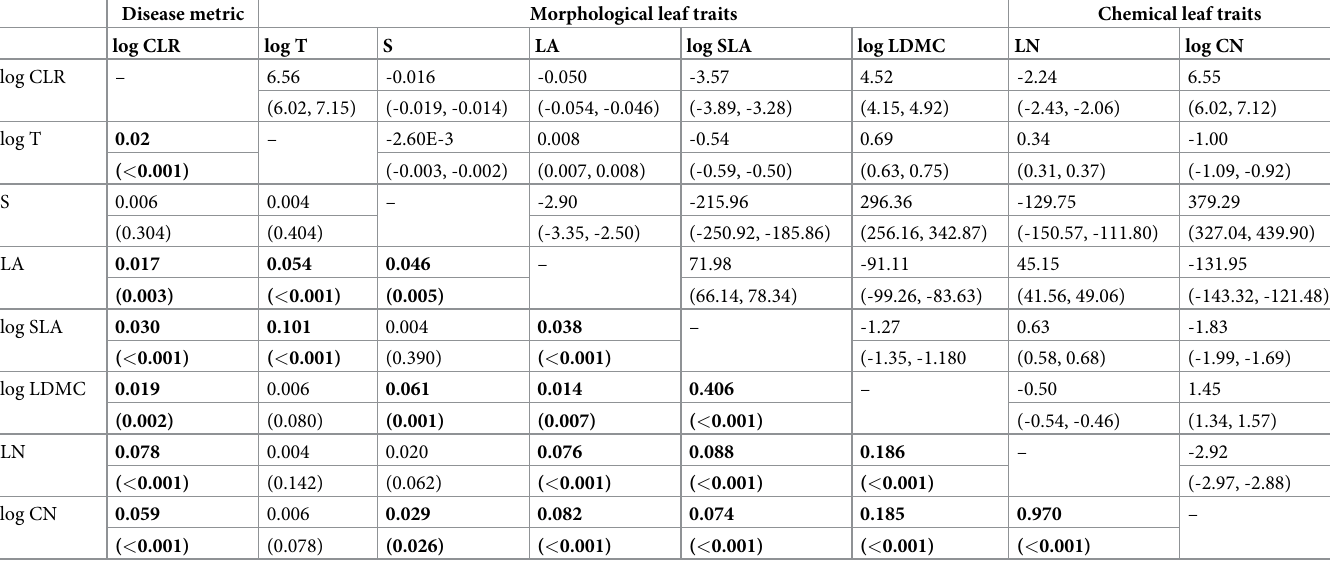
See Table 1 for trait abbreviations. Model r 2 and P -values (in brackets) for each bivariate standardized major axis regression analysis are presented in the lower left section of the matrix, with significant relationships ( P < 0.05) highlighted in bold. The upper right section of the matrix presents model slopes and associated 95% confidence intervals (in